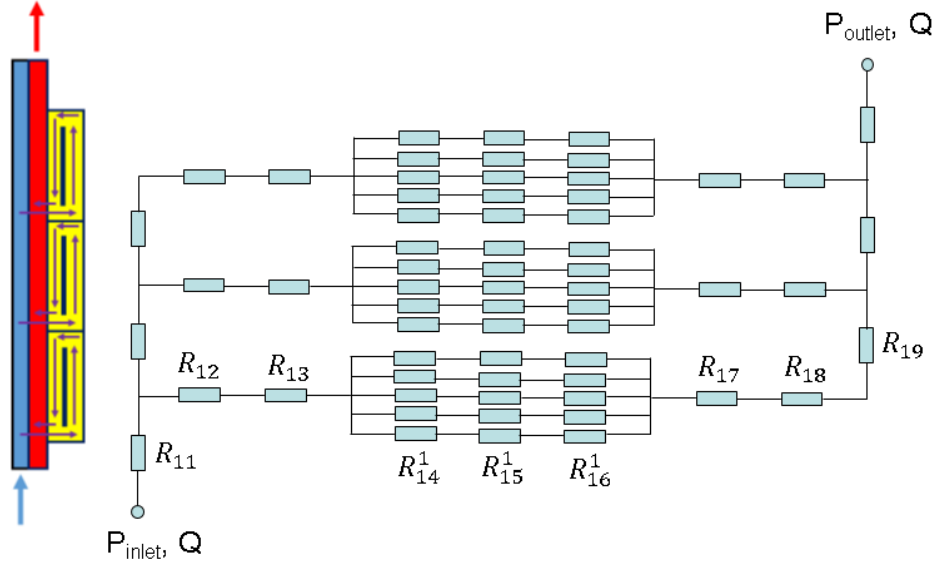
Figure 14. Schematics of modular IB DCLL blanket of three modules and an equivalent hydraulic